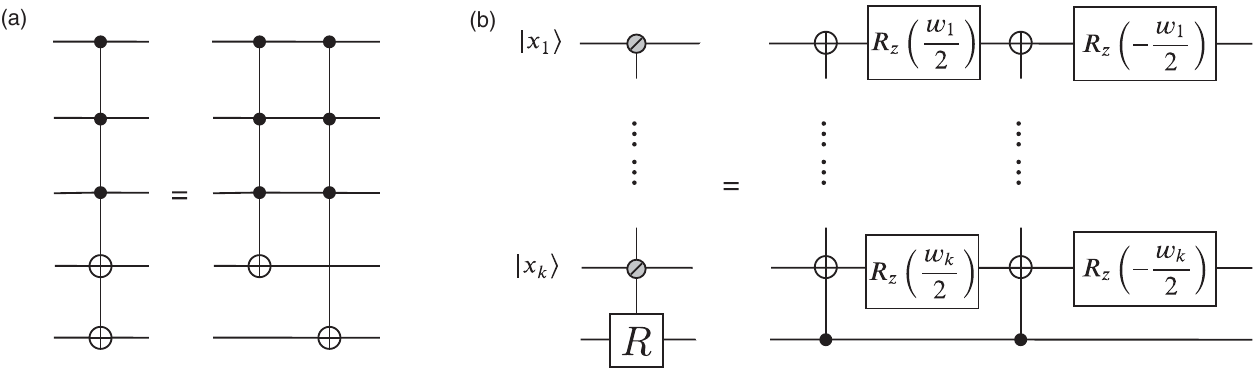
FIG. 10. Basic elements in Bayesian quantum circuits implemented by multiqubit collective gates. (a) “ Basic ” collective gate. (b) Implementation of control- R ¼ R